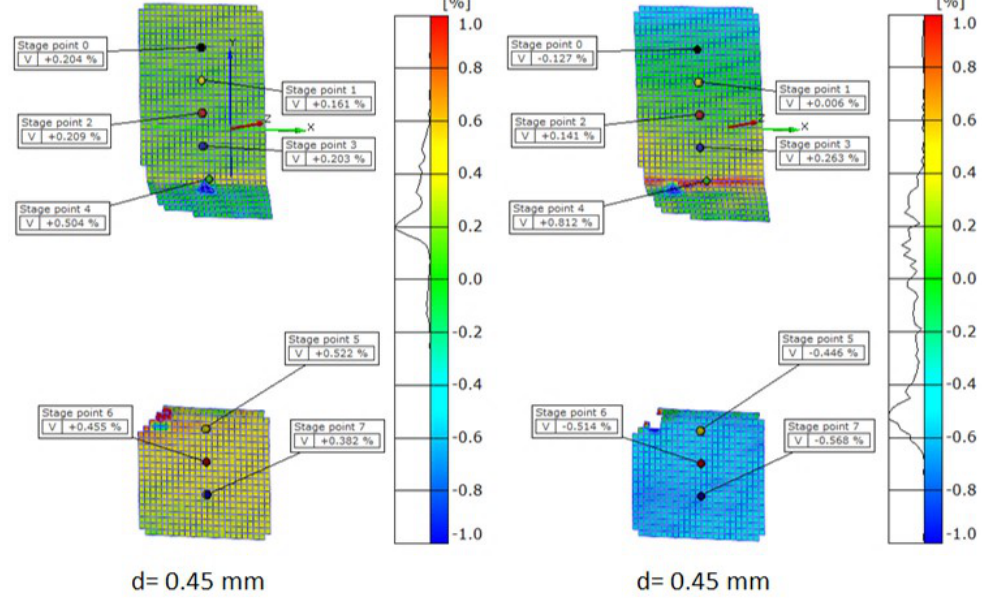
Figure 4. Longitudinal strain maps by means of DIC. (( Left ) d = 0.45 mm; ( Right ) d = − 0.45 mm.) The FE model and different materials employed in the static analyses are shown in Figure 5.